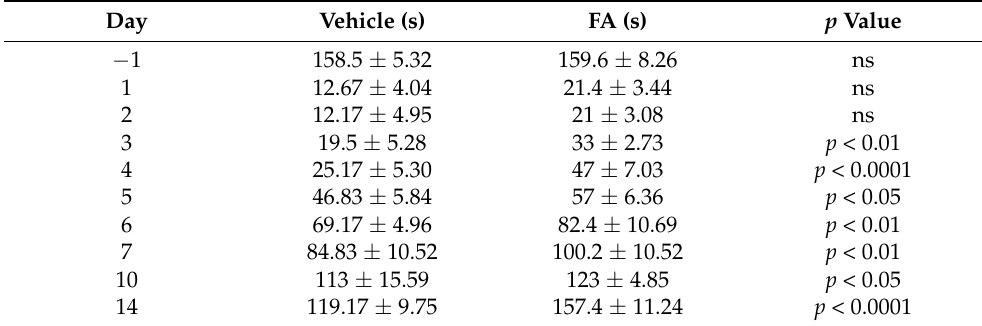
Table 2. Rotarod test values. The table represents the mean time in seconds (s) and the standard deviation for the time that untreated (vehicle) or treated (folinic acid, FA) animals remained walking on the rod. The p value indicates the statistical significance between the vehicle group and the FA-treated group (ns: p >